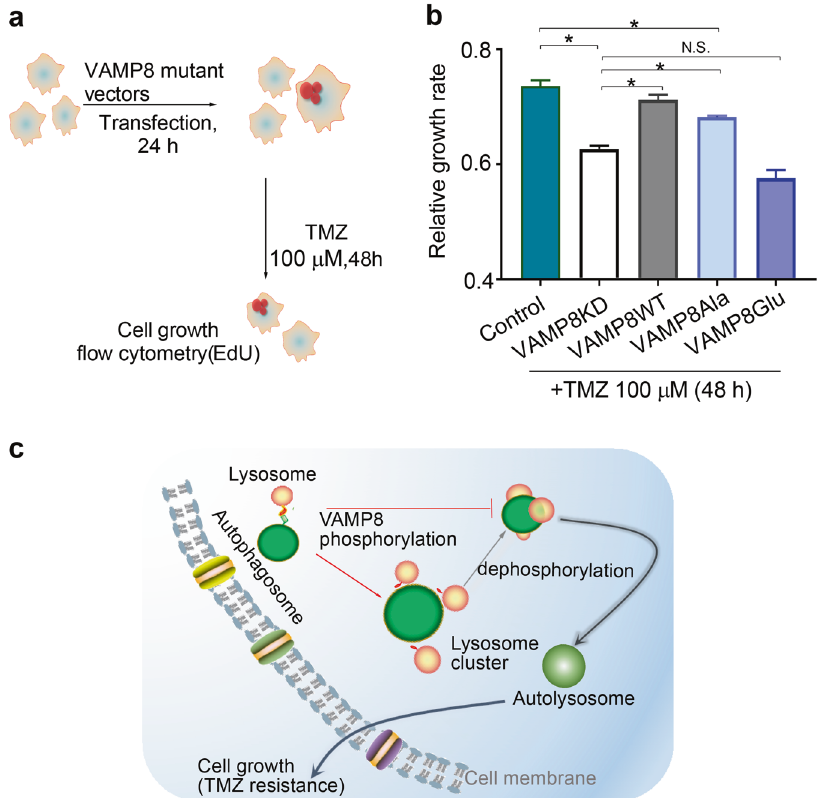
Fig. 5 Phosphorylation of VAMP8 regulates temozolomide (TMZ) resistance of HeLa cells. a Schema of TMZ resistance measurement and b Quantitative data in HeLa and VAMP8KD HeLa cells re-expressed by empty-vector, WT, VAMP8Ala, and VAMP8Glu. c Schematic representation of a VAMP8-regulated lysosome cluster on autophagosomes. VAMP8 controls the formation of lysosome clusters associated with autophagosomes, whereas its phosphorylation inhibits fusion for autophagosome maturation. Data in ( b ) are presented as mean ± SEM, * p <